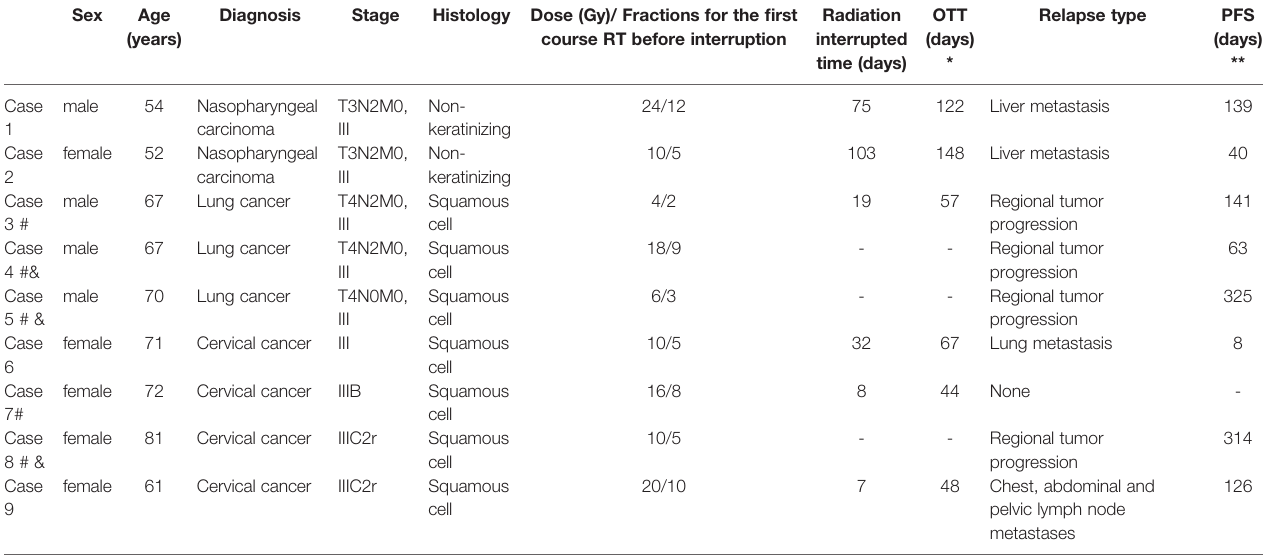
TABLE 4 | The characteristics of de fi nitive radiotherapy patients with disease progression or suffered